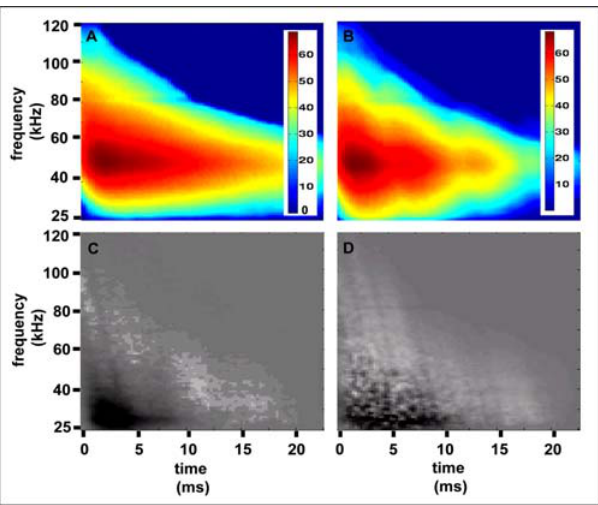
Figure 1. Decision echo analysis for the classification task of spruce vs. the rest. (A) Average spectrogram of the raw data of spruce. (B) Average spectrogram of the raw data of all the plants except spruce (i.e. the rest). The color bars for both (A) and (B) are in dB. (C) The difference of the preprocessed spectrograms of spruce and the rest. (D) The normal vector (decision echo) to the separating hyperplane calculated for this classification task. In both (C) and (D) black represents negative values, white represents positive ones, and gray is zero.